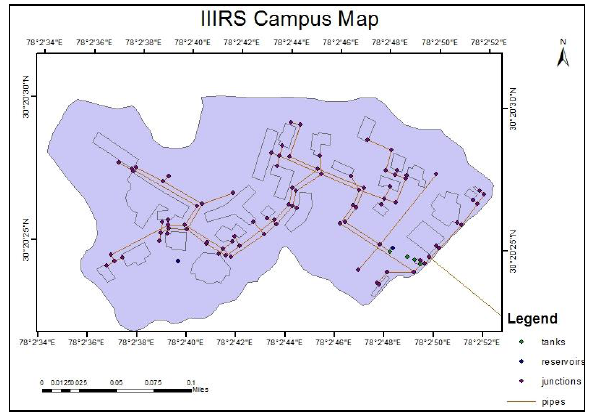
Figure 2. Existing pipe network